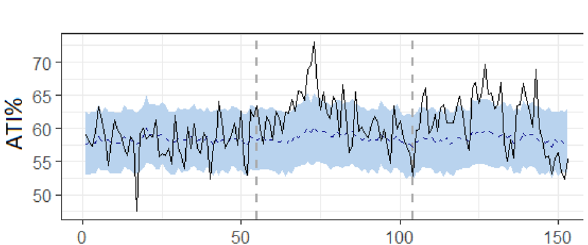
Figure 7. Chronogram of ATI weekly measures (dark line) relative to the synthetic predicted control time series (blue line). Measures are taken across Japan over the weeks from January 1st of 2019 (1) to December 5th of 2021 (n = 153). Vertical dashed grey lines represent the beginning of the COVID-19 pandemic.